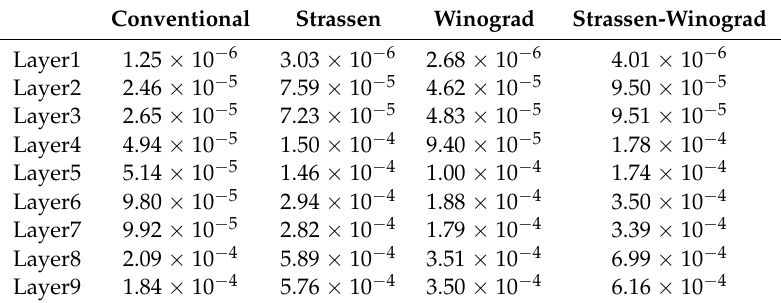
Table 4. Maximum element error of different algorithms in different